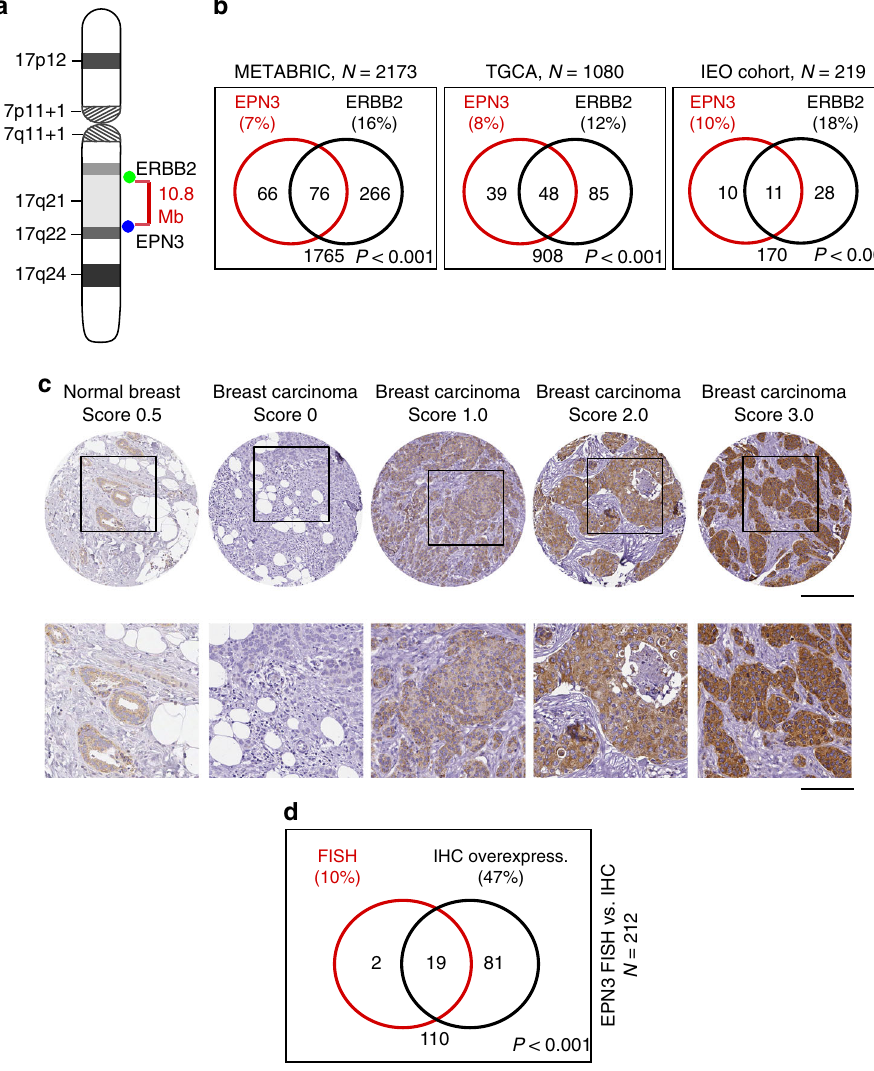
Fig. 1 Ampli fi cation/overexpression of EPN3 in human BCs. a Schematic representation of human chromosome 17. b Venn diagram of EPN3 and ERBB2 ampli fi cation in different BC cohorts: BC METABRIC cohort ( N = 2137, available at http://www.cbioportal.org) 71,72 , TCGA invasive BC cohort ( N = 1080, TCGA Research Network: http://cancergenome.nih.gov/), and the IEO cohort ( N = 219). Percentage (%) of ampli fi cation is shown in parentheses. In the IEO cohort, EPN3 and ERBB2 were considered ampli fi ed when the EPN3/CEP17 ratio was >2.5, and the ERBB2/CEP17 ratio was ≥ 2.0 60 , respectively. P, P value of the association between the indicated variables by two-sided Fisher ’ s exact test. c Representative images of EPN3 IHC (quanti fi cation scores are indicated). Top, images at 20× (bar, 200 μ m); bottom, magni fi cation of the boxed insets (bar, 200 μ m). d Venn diagram representation of EPN3 ampli fi cation (FISH) and overexpression (IHC; score >1.0) in the IEO cohort ( N = 212). P, P value of the association between the indicated variables by two- sided Fisher ’ s exact test. Source data are provided as a Source Data fi